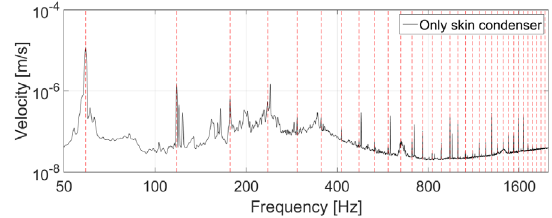
Figure 4. Vibration in the cabinet side only with skin